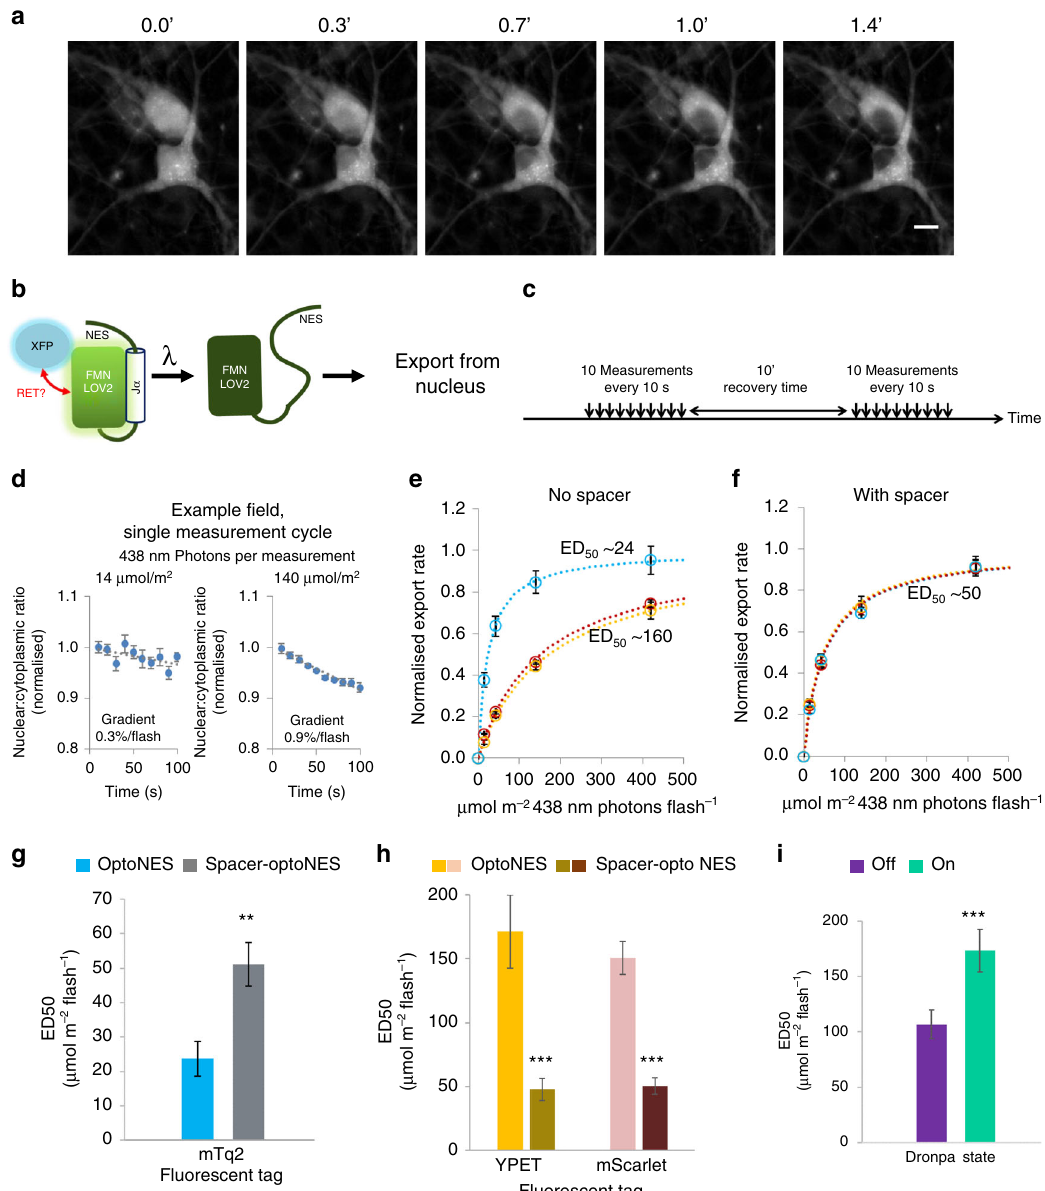
Fig. 1 Fluorescent protein tags strongly in fl uence the sensitivity of LOV2-based optogenetic nuclear export. a Blue-light induces export of mTurquoise2- tagged optogenetic nuclear export construct, mTq2-optoNES (Supplementary Fig. 4) in hippocampal neurons ( n = 8 wells at 40× magni fi cation, scalebar 10 µ m; other examples in Supplementary Fig. 5). b Fluorescent protein tags (XFP) fused to optogenetic constructs might in fl uence their sensitivity to light via RET. c Illumination scheme used to quantify light-dependency of nuclear export rates. d Example data from a single 10× fi eld treated as shown in c (four cycles, at least 10 min apart, mean ± SEM, for 23 and 31 cells, respectively), showing faster export at higher photon fl ux. e Nuclear export rate dependence on photon fl ux is shown for optoNES constructs fused to fl uorescent proteins mTurquoise2, Ypet and mScarlet (in turquoise, yellow and red, respectively) expressed in different cultures. The mTq2 construct is more sensitive (signi fi cant by F -test, F (2,66) = 41.34, P < 0.0001). Data are normalised to fi tted maximal rates to facilitate sensitivity comparison (non-normalised versions in Supplementary Fig. 9). f Corresponding experiments with a spacer between fl uorescent protein and LOV2 domain to reduce resonance energy transfer (RET, Supplementary Fig. 8). All constructs are equally sensitive to light, thus in e , mTurquoise had increased sensitivity whereas Ypet/mScarlet decreased sensitivity. This suggests RET can either increase or decrease optogenetic switch sensitivity. In e - f , all channels were imaged regardless of which XFP was used, to ensure identical illumination conditions. Data are means± SEM, n = 6 wells. Best- fi t ED µ mol 438 nm photons.m − 2 . fl ash − 1 indicated on the graphs for clarity and in Supplementary Table 1 with standard errors. 50 s in g Introduction of RET-limiting spacer reduces sensitivity (ED 50 ) of the mTq2 optoNES >twofold; F -test, F (1,44) = 10.33. h Corresponding sensitivities for the Ypet and mScarlet optoNES (from e to f ) showing introduction of spacer to limit RET increases sensitivity >threefold; F (1,44) = 23.19 and 49.86, for Ypet and mScarlet respectively; i Dronpa-optoNES shows signi fi cant difference in sensitivity in Dronpa-off and Dronpa-on states; F (1, 45) = 49.51. g – i show best- fi t values ± S.E. (** P = 0.0025, *** P < 0.0001) from curve- fi tting of datasets in e , f and Supplementary Fig. 9F. Source data are provided as a Source Data fi